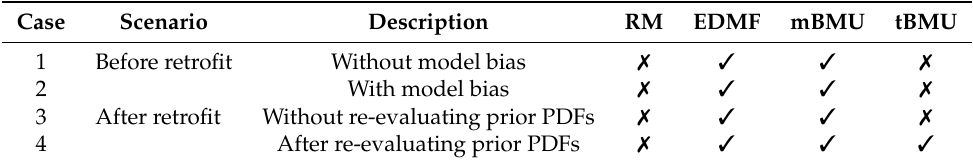
Table 14. Summary of the accuracy of structural identification scenarios (see Table 4) evaluated for the Ponneri Bridge. mBMU is modified BMU and tBMU is traditional BMU. Checkmarks imply accurate identification and crosses imply inaccurate identification.